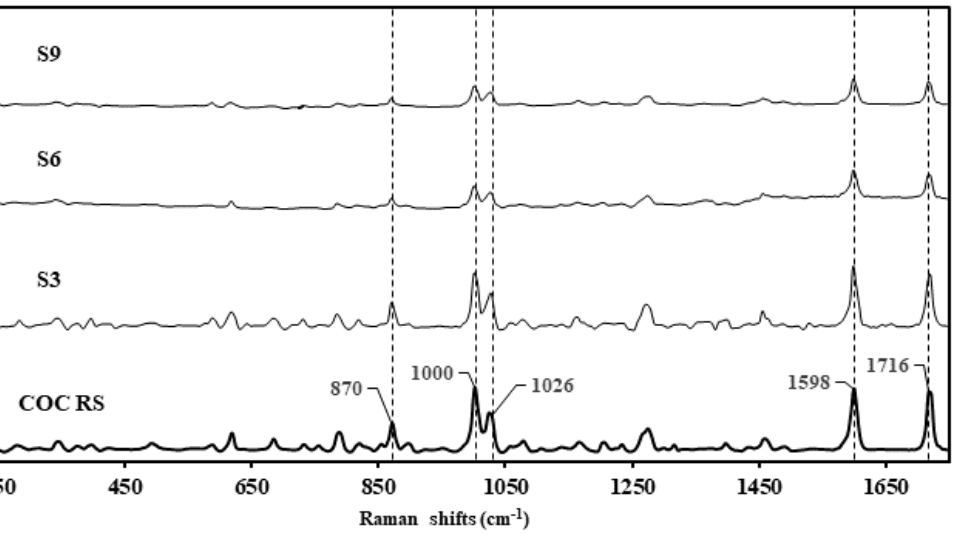
Figure 3. Raman spectra of cocaine reference standard (COC RS) stacked against the surrendered samples, S3, S6 and S9, declared as cocaine samples by the clients. samples, S3, S6 and S9, declared as cocaine samples by the